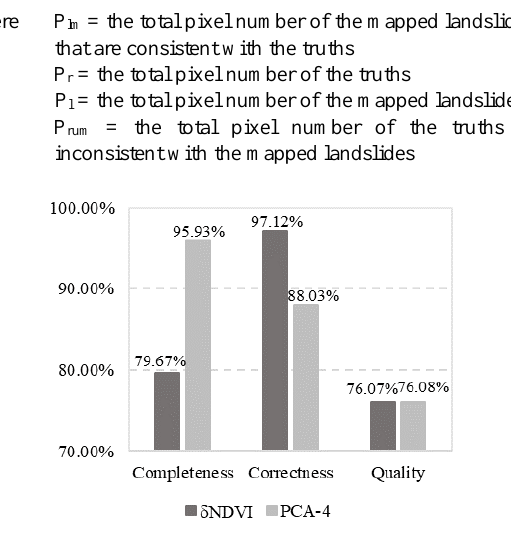
Figure 5. The histogram of accuracy assessment for LIM in the study